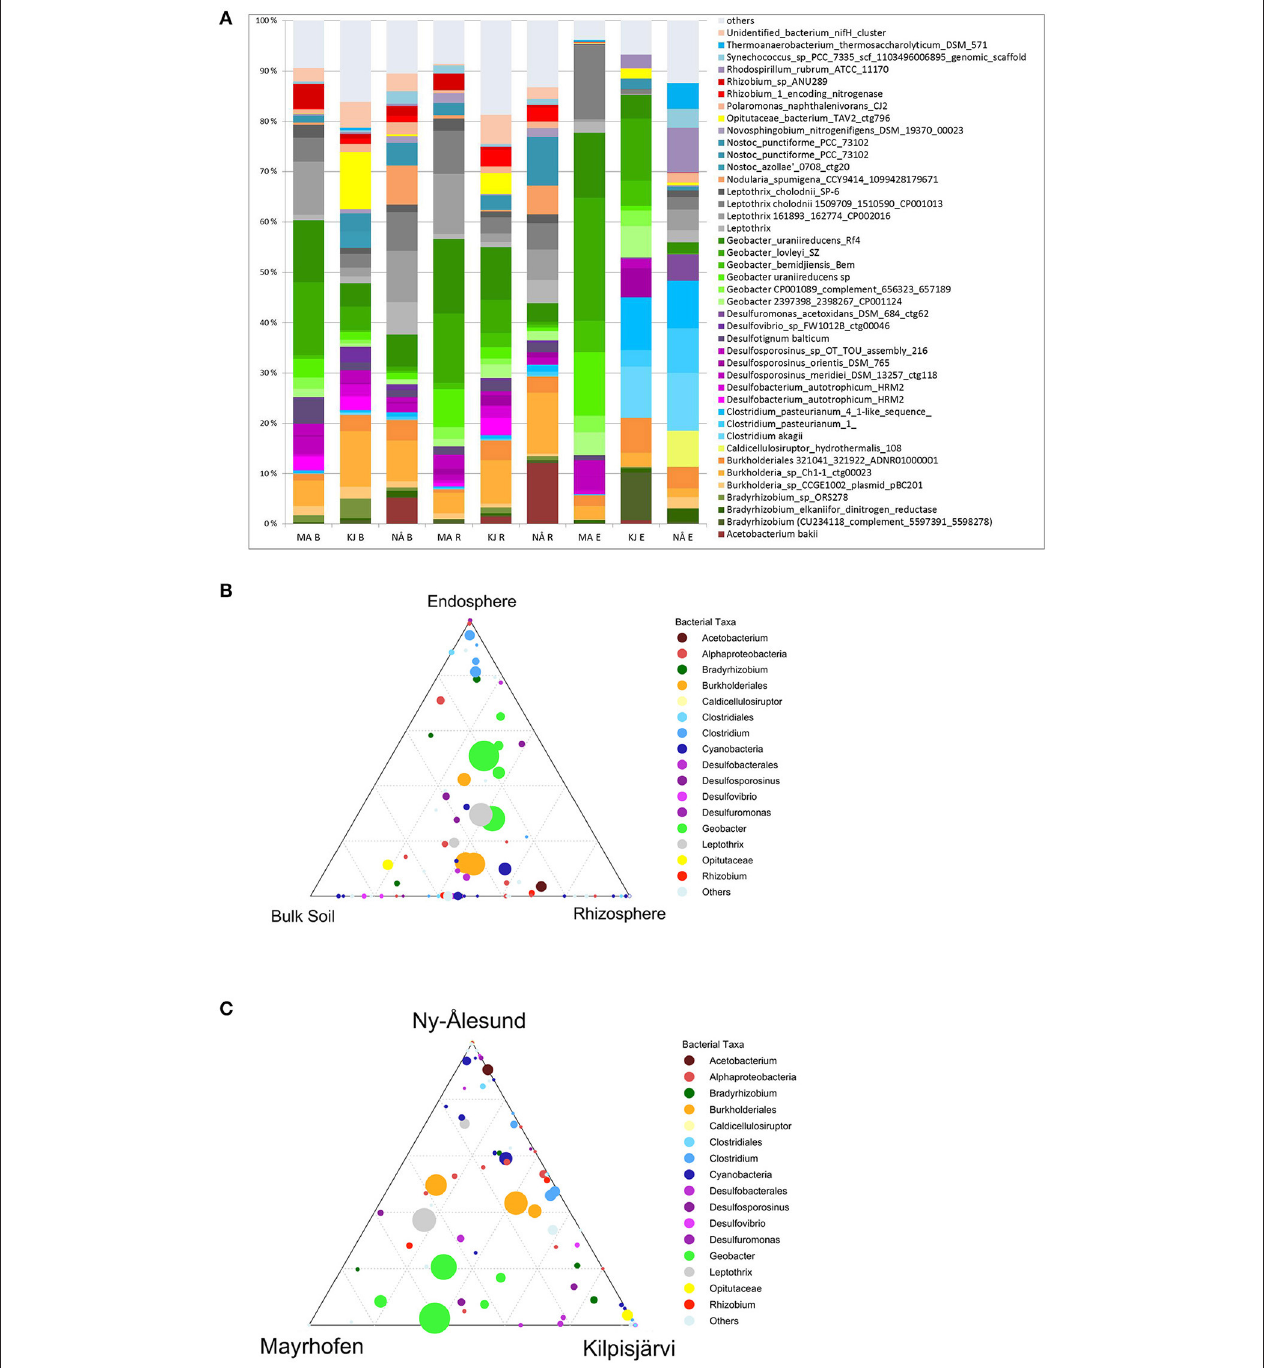
FIGURE 5 | Average relative abundances (A) and distribution of OPUs (B,C) in different sample compartments and geographic regions. (A) Average relative abundances (four biological replicates) of PNFB communities in different sample compartments and geographic regions. Compartments: B, bulk soil; R, rhizosphere soil; E, endosphere; MA, Mayrhofen; the Alps; KJ, Kilpisjärvi; Low Arctic, NÅ, Ny-Ålesund; High Arctic. Only major PNFB OPUs (relative abundance above 1%) are indicated, OPUs with < 1% relative abundance are grouped together (“others”). (B) Ternary plot of distribution of OPUs across different compartments. Each circle represents one OPU. The size of the circle represents the average relative abundance of the OPU in the dataset. The circle color corresponds to OPUs taxonomic affiliation. Location of the circle in the plot in relation to different compartments indicates the contribution of each compartment to the OPU’s total relative abundance, with the dotted grid inside the plot area indicating 20% increments of contribution. (C) Ternary plot of distribution of OPUs across different regions. Similar to (B) , the size, the color and the location of each circle indicates the average relative abundance, taxonomic affiliation and association with different regions of the corresponding